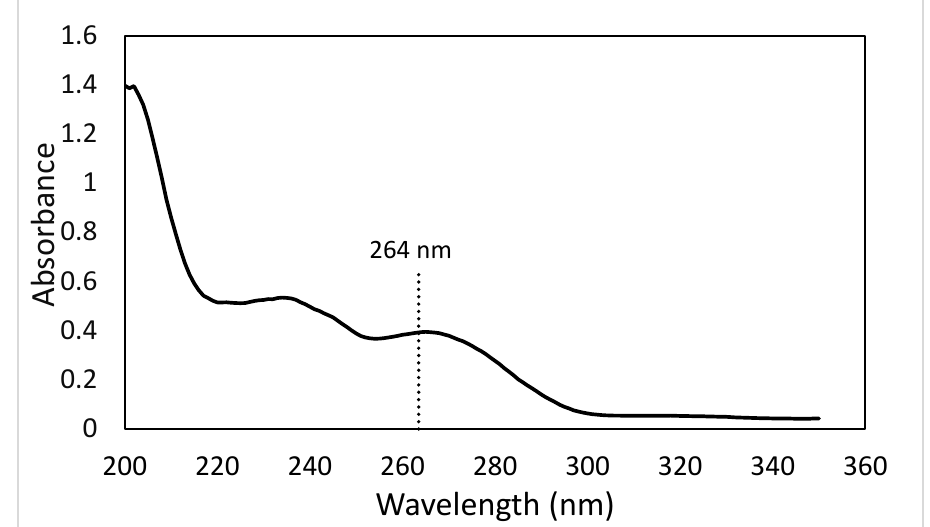
Figure 8. Average absorbance spectrum in the 200–350 nm region for leaflet washes obtained from the BC2F3 generation plants. The vertical dashed line identifies 264 nm, the λ max of isolated 7-epi zingiberene.